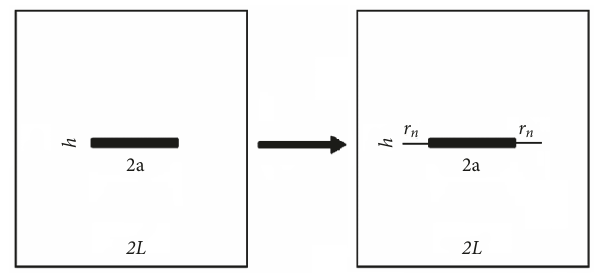
Figure 1: Schematic illustration of rock mass damage evolution induced by multiblasting.